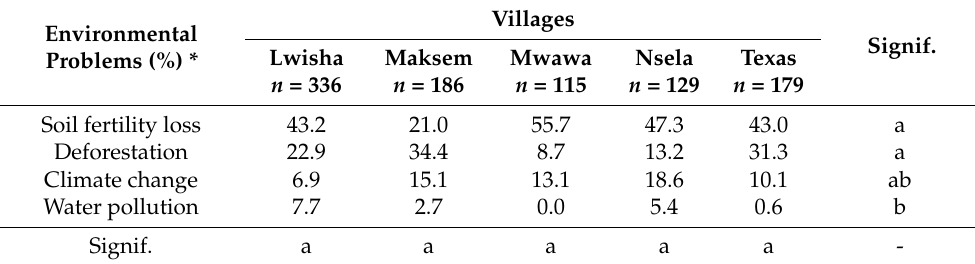
Table 4. Main environmental problems perceived in the different villages of the Lubumbashi ru- ral